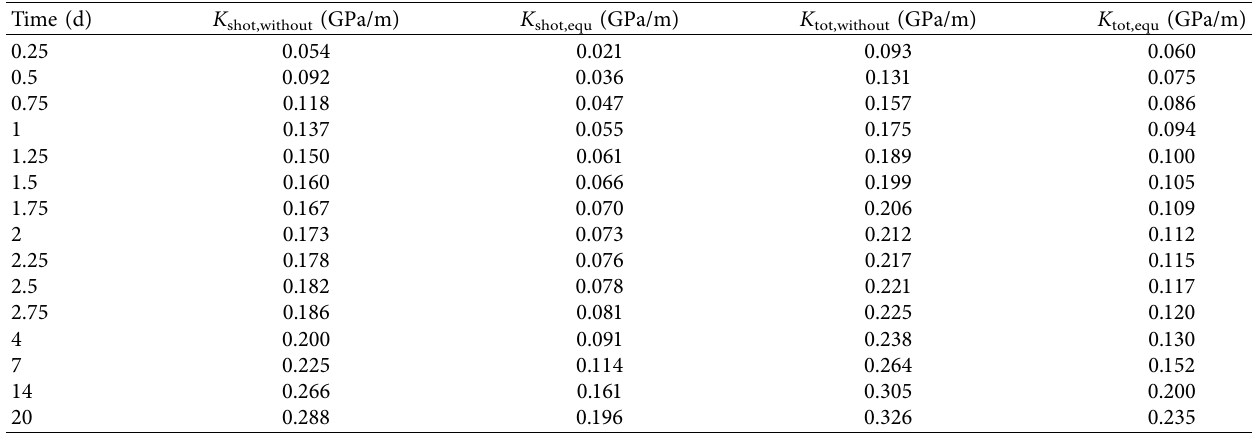
Figure 5: Relation diagram of elastic modulus, creep coefficient, and age. Table 7: Stiffness of supporting